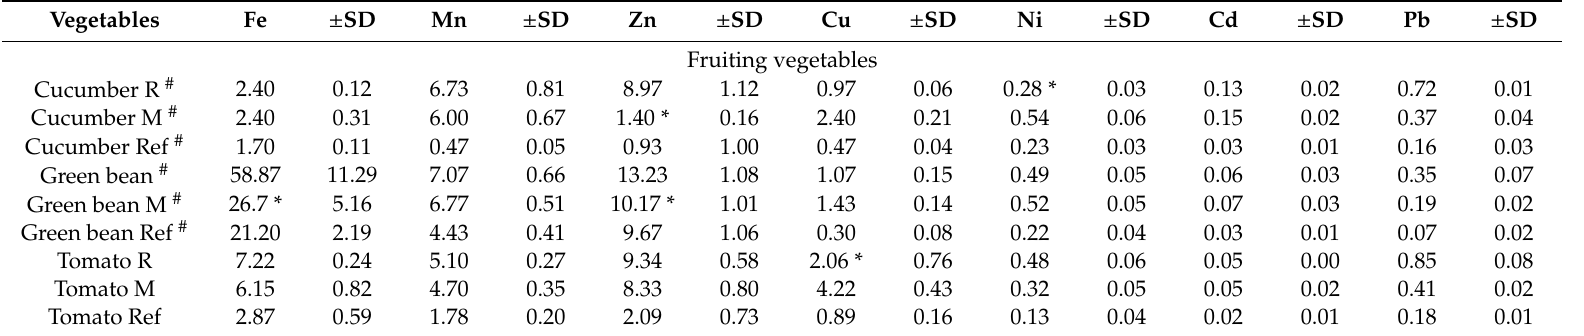
Table 4. Mean (and SD) for metal concentrations in analyzed fruiting vegetables (mg / kg FW).